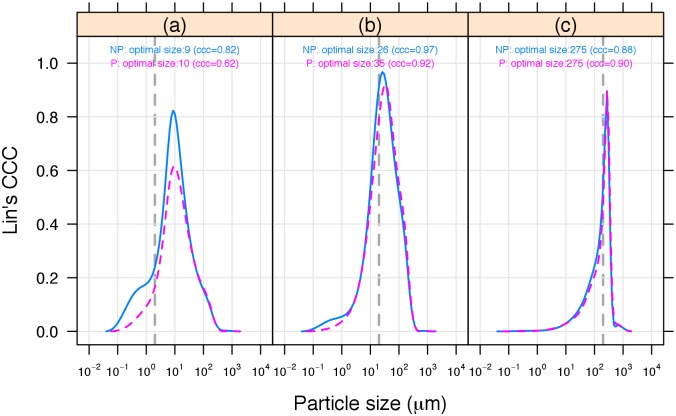
Plots of Lin’s concordance correlation coefficient (CCC) for different laser diffraction (LDM) equivalent sieve sizes.Peak in Lin’s CCC provides the LDM equivalent thresholds that best match the SPM thresholds (shown as a vertical dashed line) of: (a) < 2 μm. (b) < 20 μm. (c) < 200 μm. NP, solid blue line; P, dashed red line.